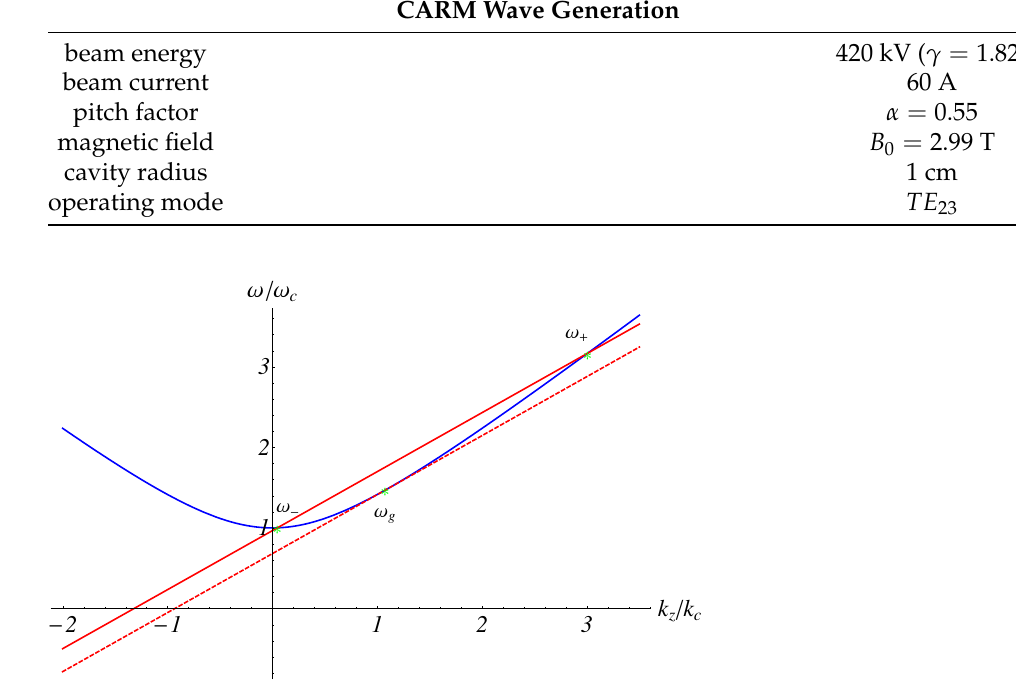
Figure 9. Beam-wave cold cavity interaction in the Brillouin diagram ( ω , k ) normalized to the cutoff frequency ( ω c ) and to the wave vector ( k c ) using the parameters reported in Table 1. The transition from the condition of two operating frequency (two intersections ω − , ω + continuous line) to that of grazing incidence ( ω − = ω + = ω g dashed line) is obtained by changing, i.e., the magnetic field intensity from B 0 = 2.99 T to 2.1 T.